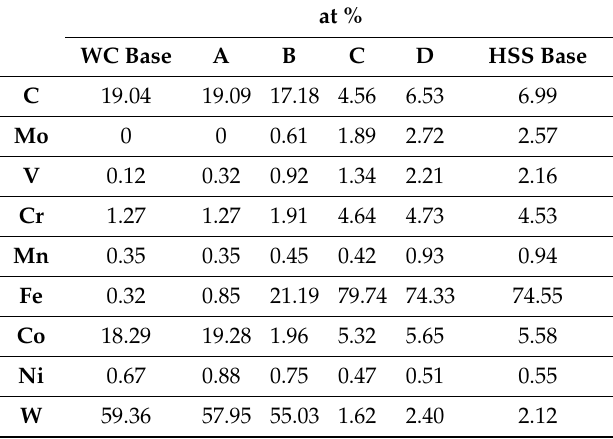
Figure 15. EDS chemical (at%) maps of the HSS / WC-Co interface (region W2 in Figure 2). Scan size of 50 × 40 µ m. The white arrows in the Co map indicate that the transitional layer is composed of both a Co depleted zone (CDZ) and a Co enriched zone (CEZ). The blue and yellow arrows in the SEI image indicate composite and HSS side boundaries of the transitional layer, respectively. Table 2. Semi-quantitative EDS analyses of various regions indicated in Figures 14 and 16, compared with the EDS average composition of both the high-speed steel (HSS) base and composite base materials. The tungsten carbide (WC) base material composition data are taken from [47]. at